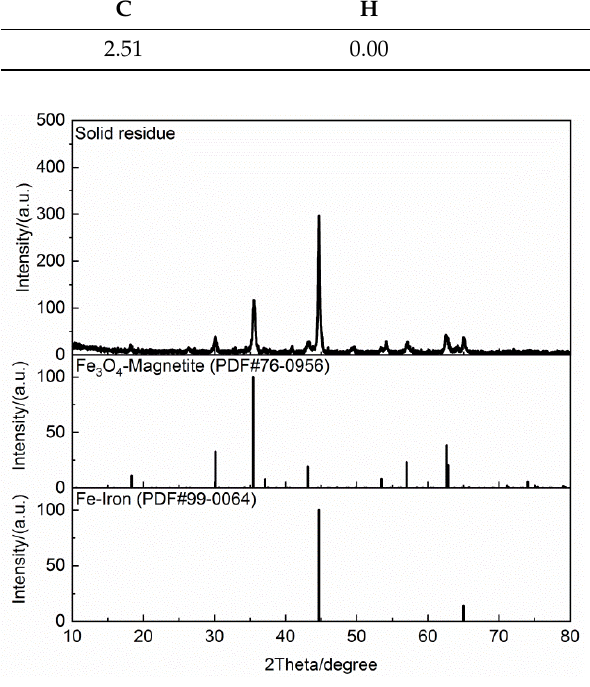
Figure 6. XRD patterns of the solid residue generated during oily sludge pyrolysis. Table 8. Ultimate analyses of the solid residue (wt %).